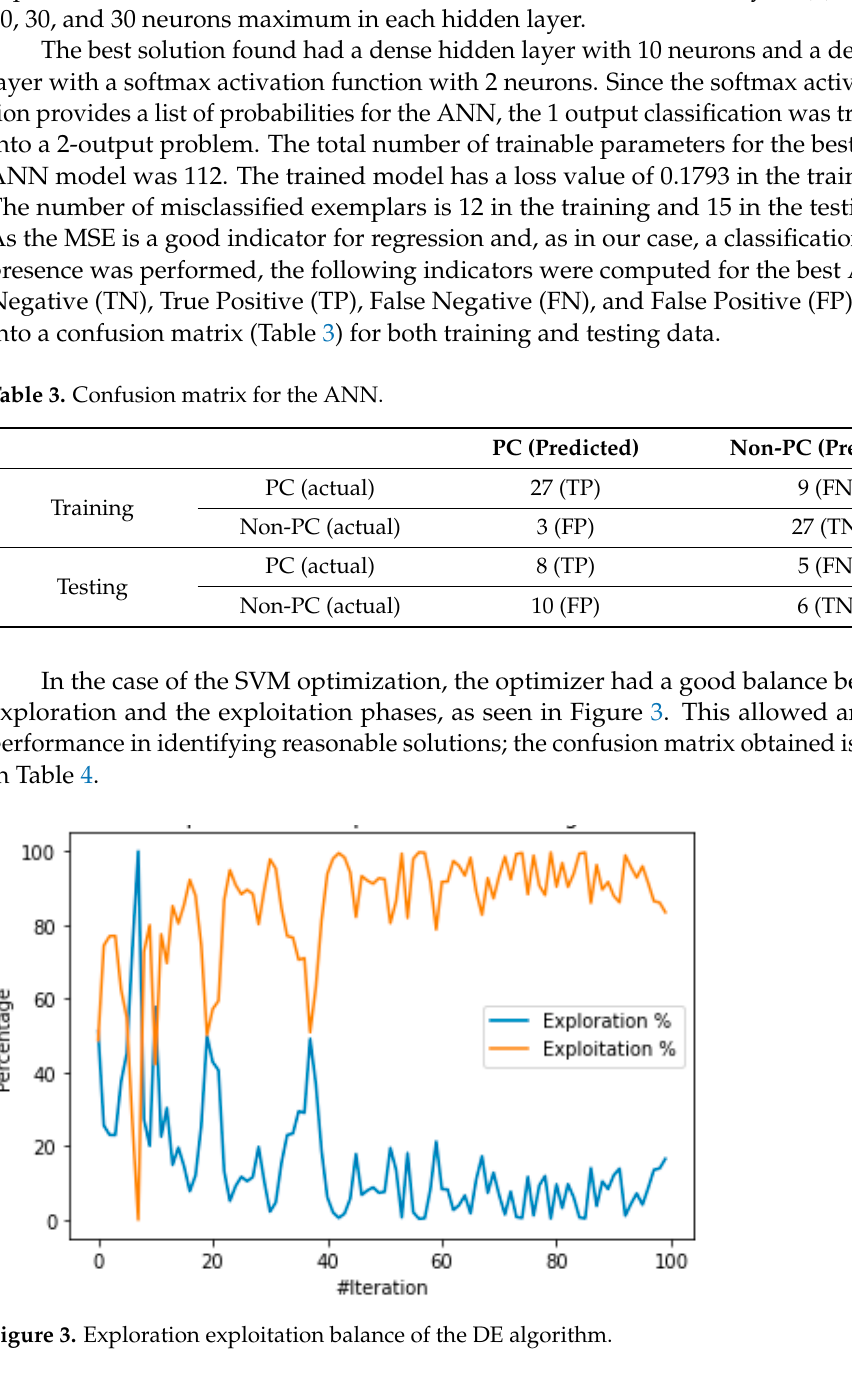
Table 5. Confusion matrix for the RF.